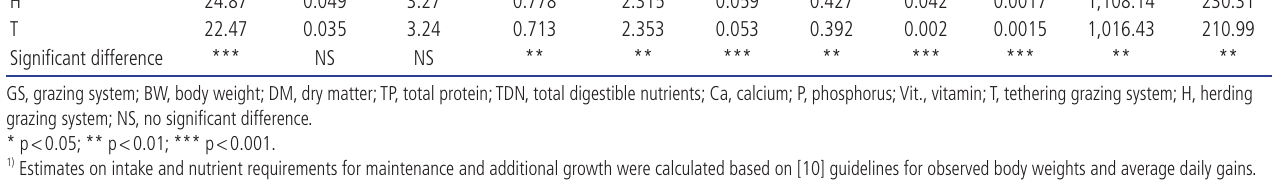
Table 5. Body weights, average daily gains, body condition scores and estimated intake requirements for maintenance and growth of tethered and herded goats 1) GS